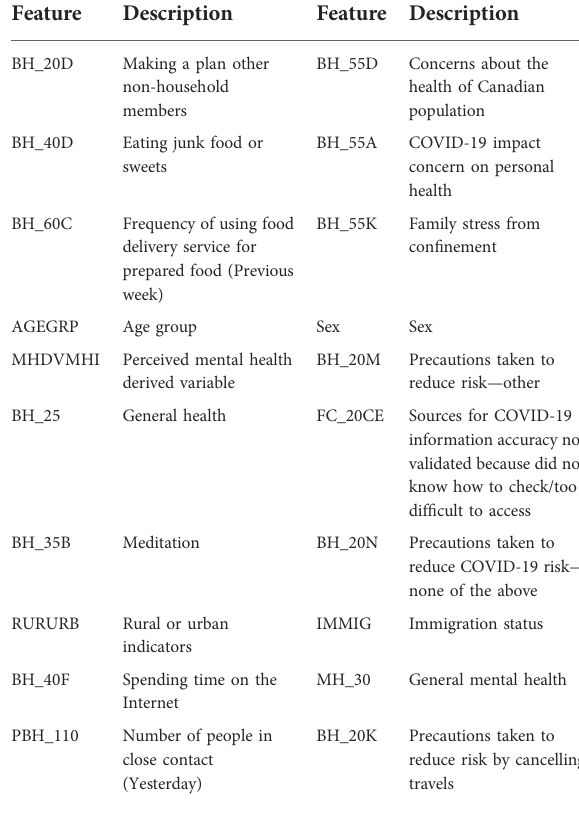
TABLE 4 Reduced feature set for the fi rst phase of COVID-19 through